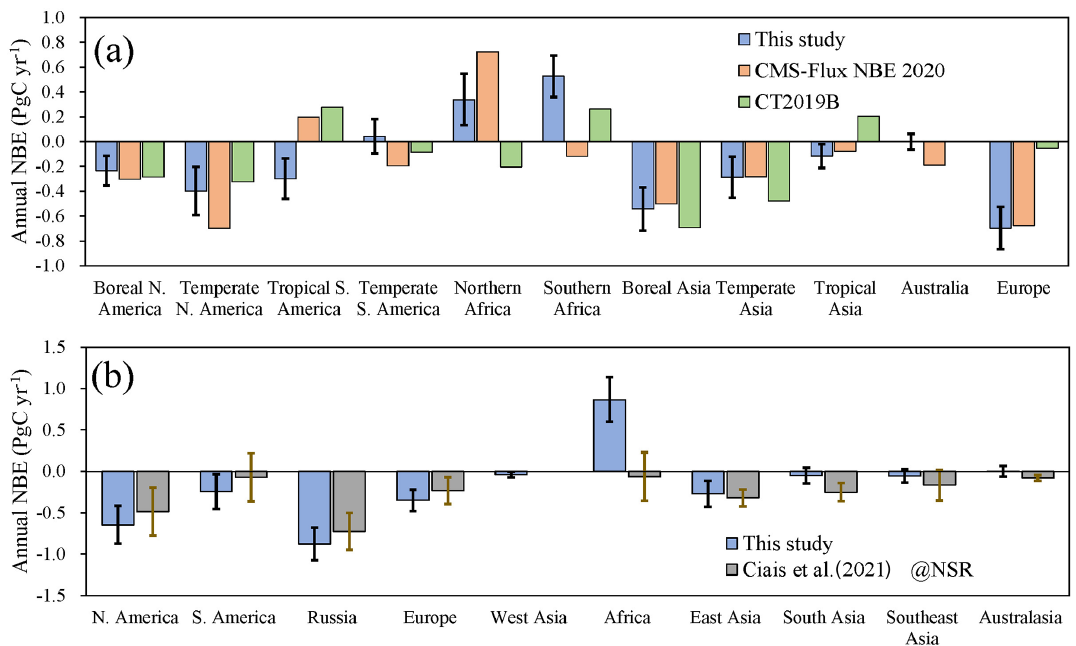
Figure 6. 2010–2019 averaged regional NBE in (a) the TRANSCOM regions and (b) the RECCAP2 regions. Both CMS-Flux NBE 2020 and CT2019B are averaged from 2010 to 2018. The result of Ciais et al. (2021) is a bottom-up estimate, which is for the period of 2000–2009.